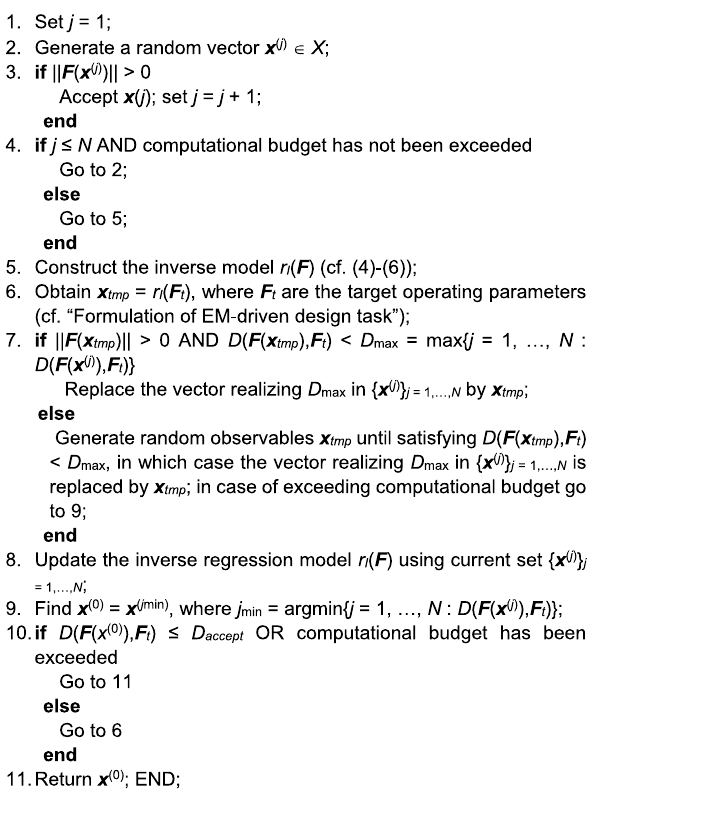
Figure 4. Pseudocode of the globalized optimization of microwave components using inverse regression model. The presented flow represents the first (global) optimization stage, which is followed by a local optimization (cf. “Local optimization